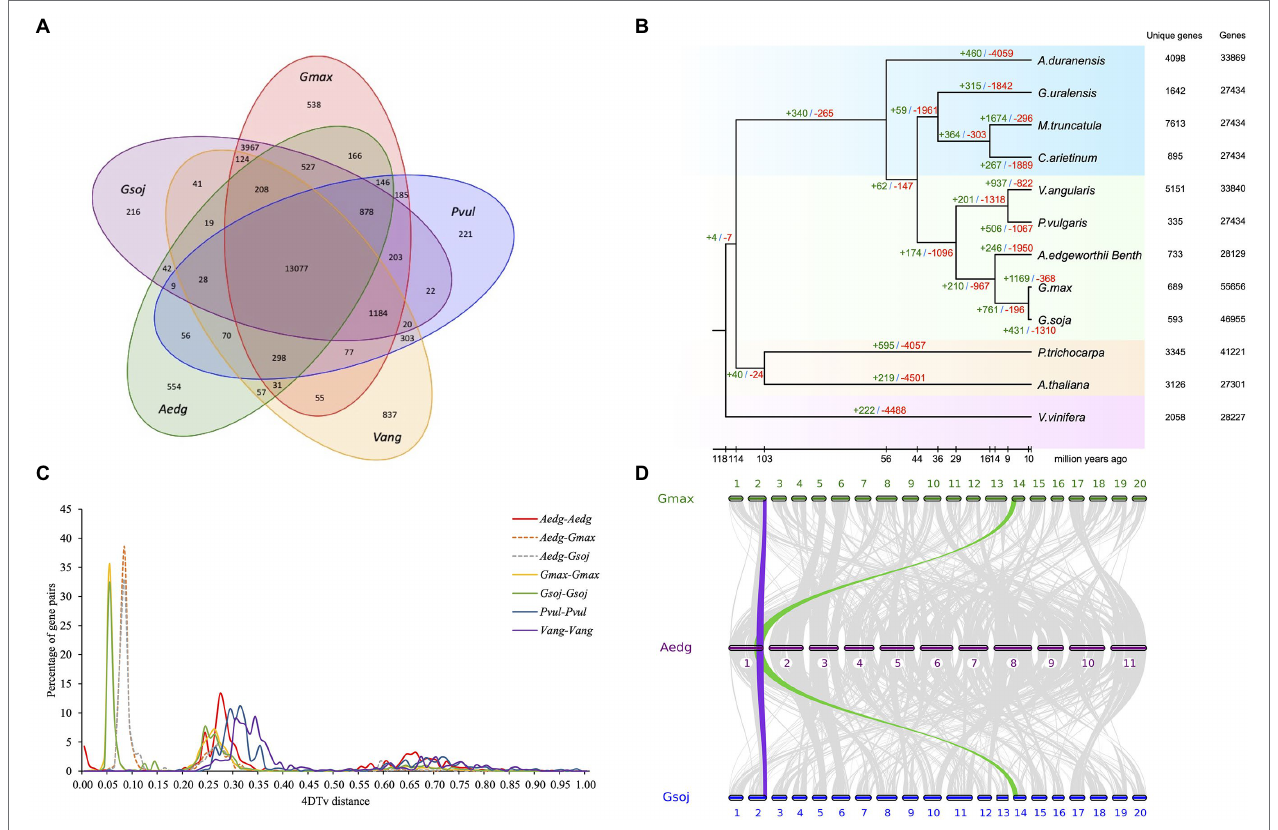
FIGURE 3 | Comparative genomic analysis of A. edgeworthii and 11 other plant species. (A) Comparison of the number of gene families identified using OrthoMCL. Venn diagram showing unique and shared gene families between the genomes of A. edgeworthii and 4 other legume species. (B) Expansion and contraction of gene families among 12 plant species. The number of expanded (green) and contracted (red) gene families is shown above the branches. (C) The abscissa represents the transversion substitutions at 4-fold degenerate sites (4DTv) distance, and the ordinate indicates the percentage of gene pairs corresponding to the 4DTv values. (D) Syntenic analysis. Synteny blocks shared between A. edgeworthii and its close relatives Glycine max and Glycine soja . We identified 383 syntenic blocks between A. edgeworthii and G. max genomes and 376 synteny blocks between the A. edgeworthii and G. soja genomes. Gray ribbons connect the matching gene pairs. Colored lines show an example of syntenic blocks found in other species, corresponding to one copy in the A. edgeworthii genome and 2 copies in G. max and G. soja